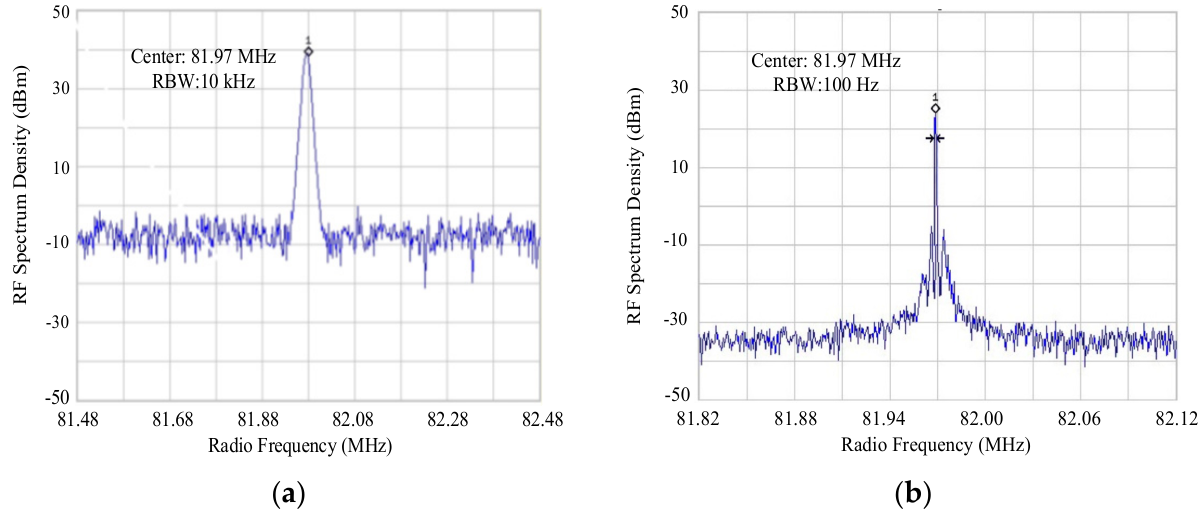
Figure 6. Measurement results of spectrometer in two states: ( a ) CWML operation state; ( b ) QML operation state.